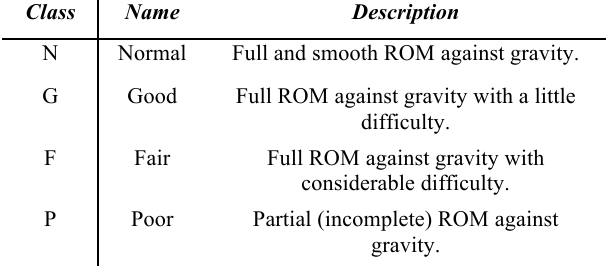
Figure 2: Sample Plots of Accelerometer data along Y-axis (left) and Gyroscope data along Z-axis (right) against time steps during the simulation of different muscle qualities. Table 2: Description of the four levels of muscle